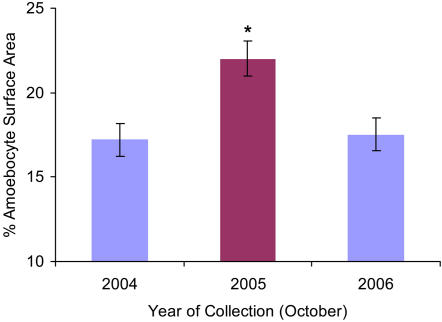
Amoebocyte surface area is higher in sea fans samples during the 2005 bleaching event.Data presented are mean±s.e.m, n = 6, X
2 = 24.51, p<0.0001. Asterisk denotes significant differences at p<0.05.